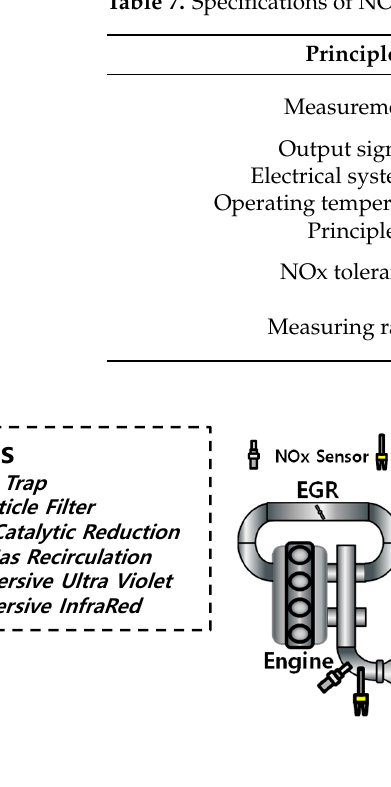
Figure 5. Schematic diagram of the PEMS and SEMS equipment installed on the test